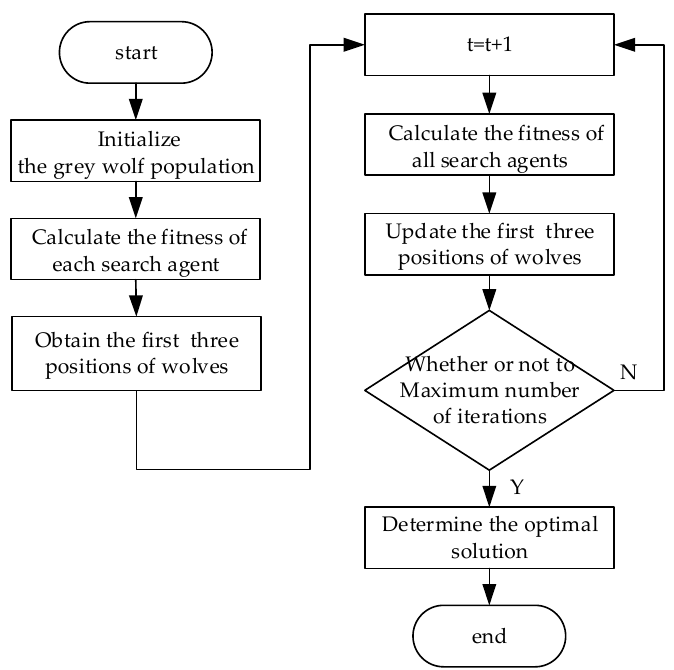
Figure 1. The flow chart of grey wolf optimization algorithm.